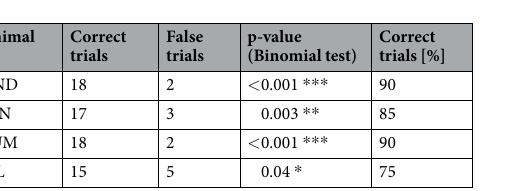
Table 3. Discrimination of conspecific vs. heterospecific urine odour across the last 20 trials in